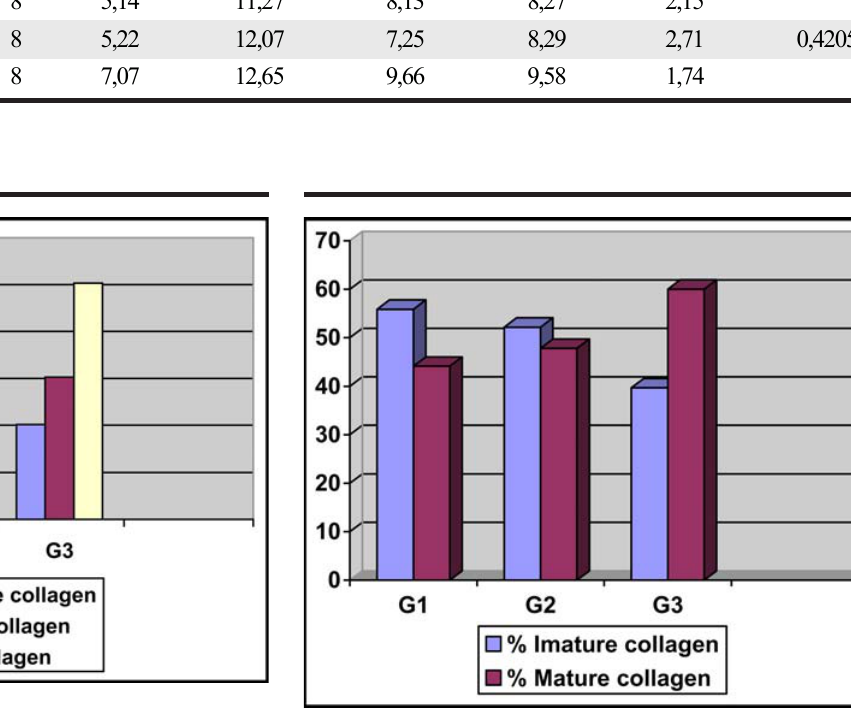
FIGURE 2 - Behavior of the percentage of the two types of